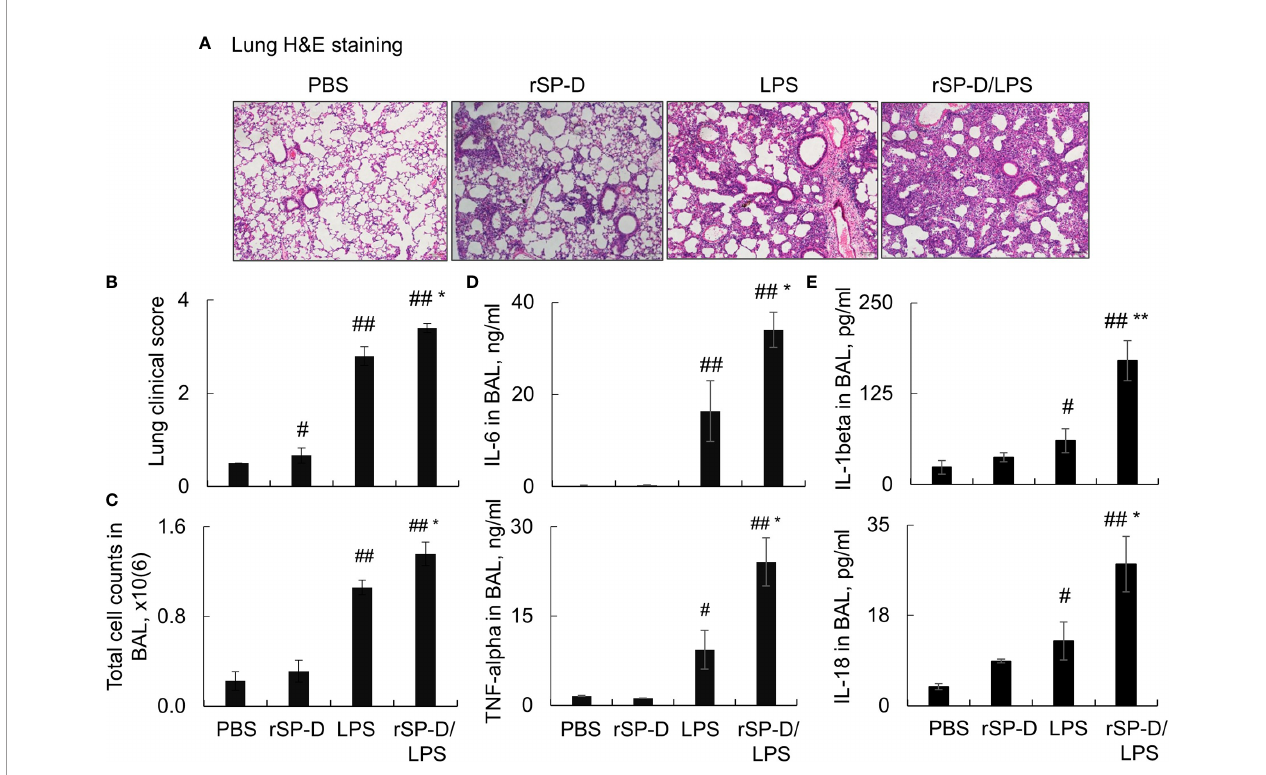
FIGURE 5 | Recombinant murine surfactant protein D (rSP-D) enhanced the severity of acute lung injury (ALI) in mice. C57BL/6 mice were co-i.t. treated with both 0.3 mg/kg rSP-D and 5 mg/kg lipopolysaccharide (LPS) (rSP-D/LPS group) for 2 days. The mice treated with phosphate buffered saline (PBS), rSP-D, LPS alone were controls. (A) Lung histology by H&E staining. Representative photograph with magni fi cation ×100. (B) Quantitative analysis of lung histology in each group. (C) Total cell counts in bronchoalveolar lavage (BAL). (D, E) ELISA assay for the expression of interleukin (IL)-6, tumor necrosis factor (TNF)-alpha, IL-1beta, and IL-18 in BAL. All data were presented as mean ± SE. n = 7 (LPS and rSP-D/LPS groups) or 3 (PBS and rSP-D groups). *p < 0.05, **p < 0.01 vs . immunoglobulin G (IgG)/LPS group; # p < 0.05, ## p < 0.01 vs . PBS